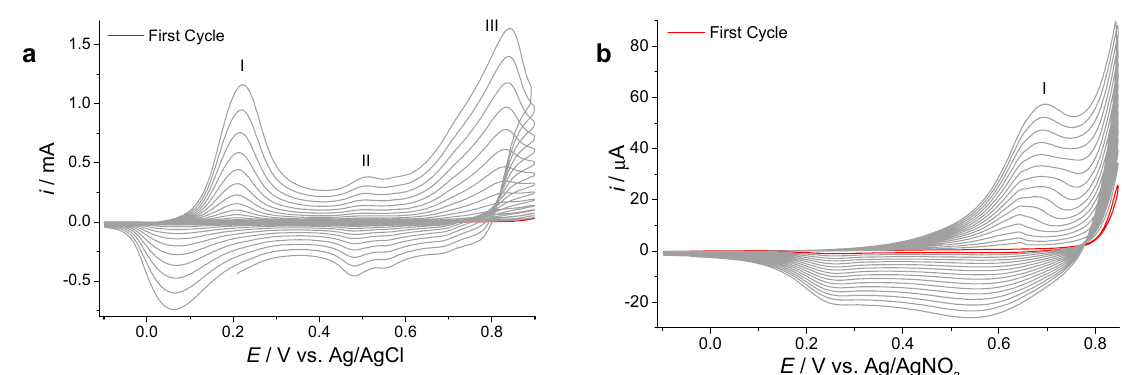
Figure 1. ( a ) Cyclic voltammograms (CVs) for electropolymerization of 0.4 M aniline in an aqueous 0.5 M sulfuric acid solution at platinum disc electrodes. ( b ) Cyclic voltammograms for electropolymerization of 2 mM bithiophene and 0.1 M tetrabutylammonium perchlorate solutions in MeCN at platinum disc electrodes. The voltammograms were recorder from − 0.1 to 0.9 V (polyaniline (PANI)), or 0.85 V (polybithiophene (PBTh)) with a sweep rate of 0.1 V s − 1 . Both polymers show a distinct electrochromism behavior, i.e., the film changed color when different redox potentials were applied. In the case of PANI, it is possible to differentiate three chemical and electronic structures—leucoemeraldine, emeraldine, and pernigraniline—all showing different colors and electronic properties (see Scheme 2) [32,40,41].